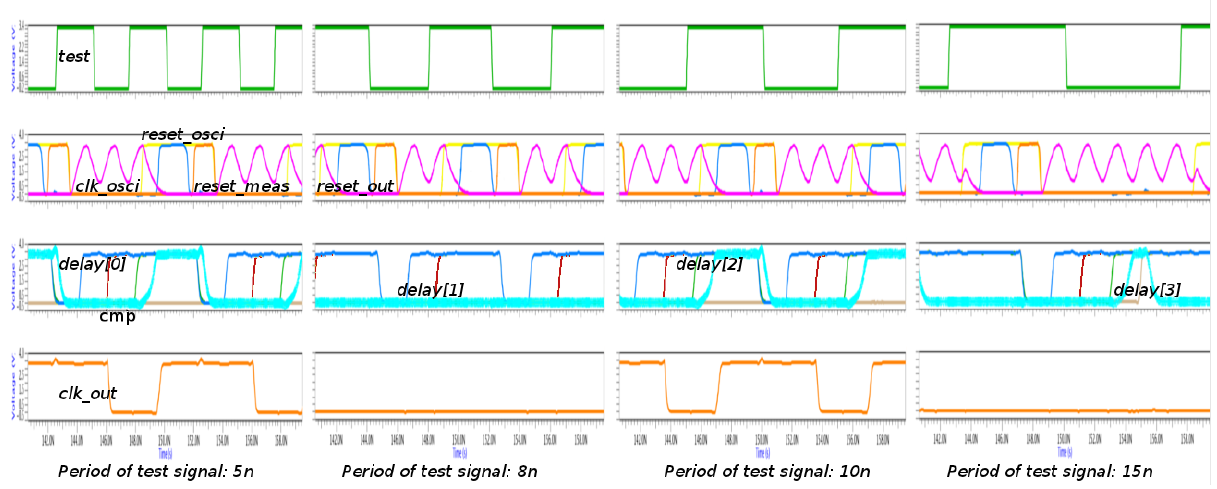
Figure 8. Behavior of VLSI sensor varying the period of test